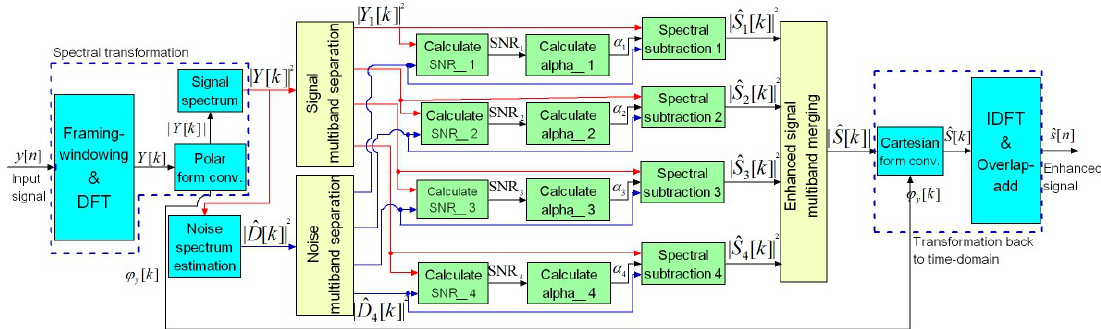
Figure 1. Block diagram of the multi-band spectral subtraction for speech enhancement. DFT: discrete Fourier transform; IDFT: inverse discrete Fourier